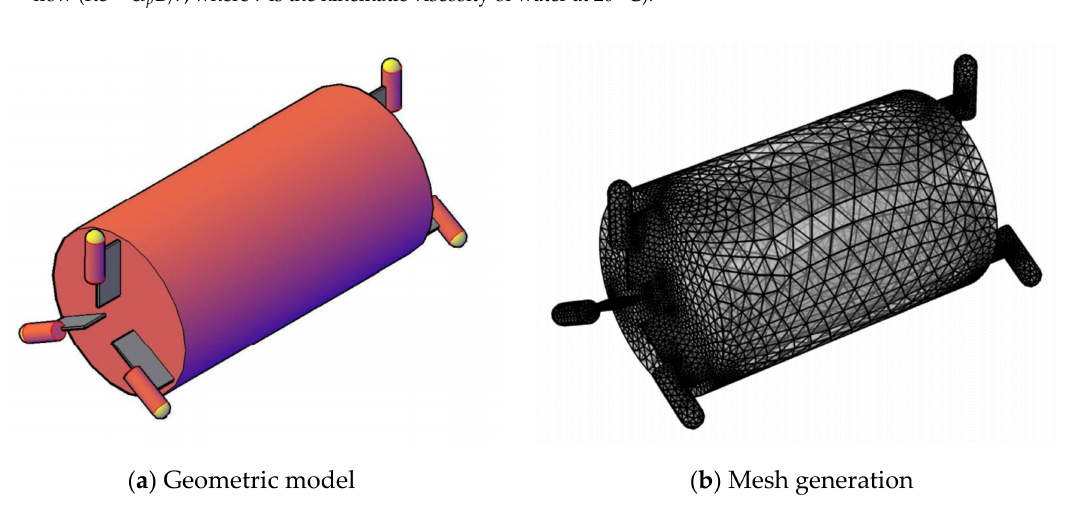
Figure 3. Geometric model and mesh generation of the piped carriage. ( a ) Geometric model, ( b ) Mesh